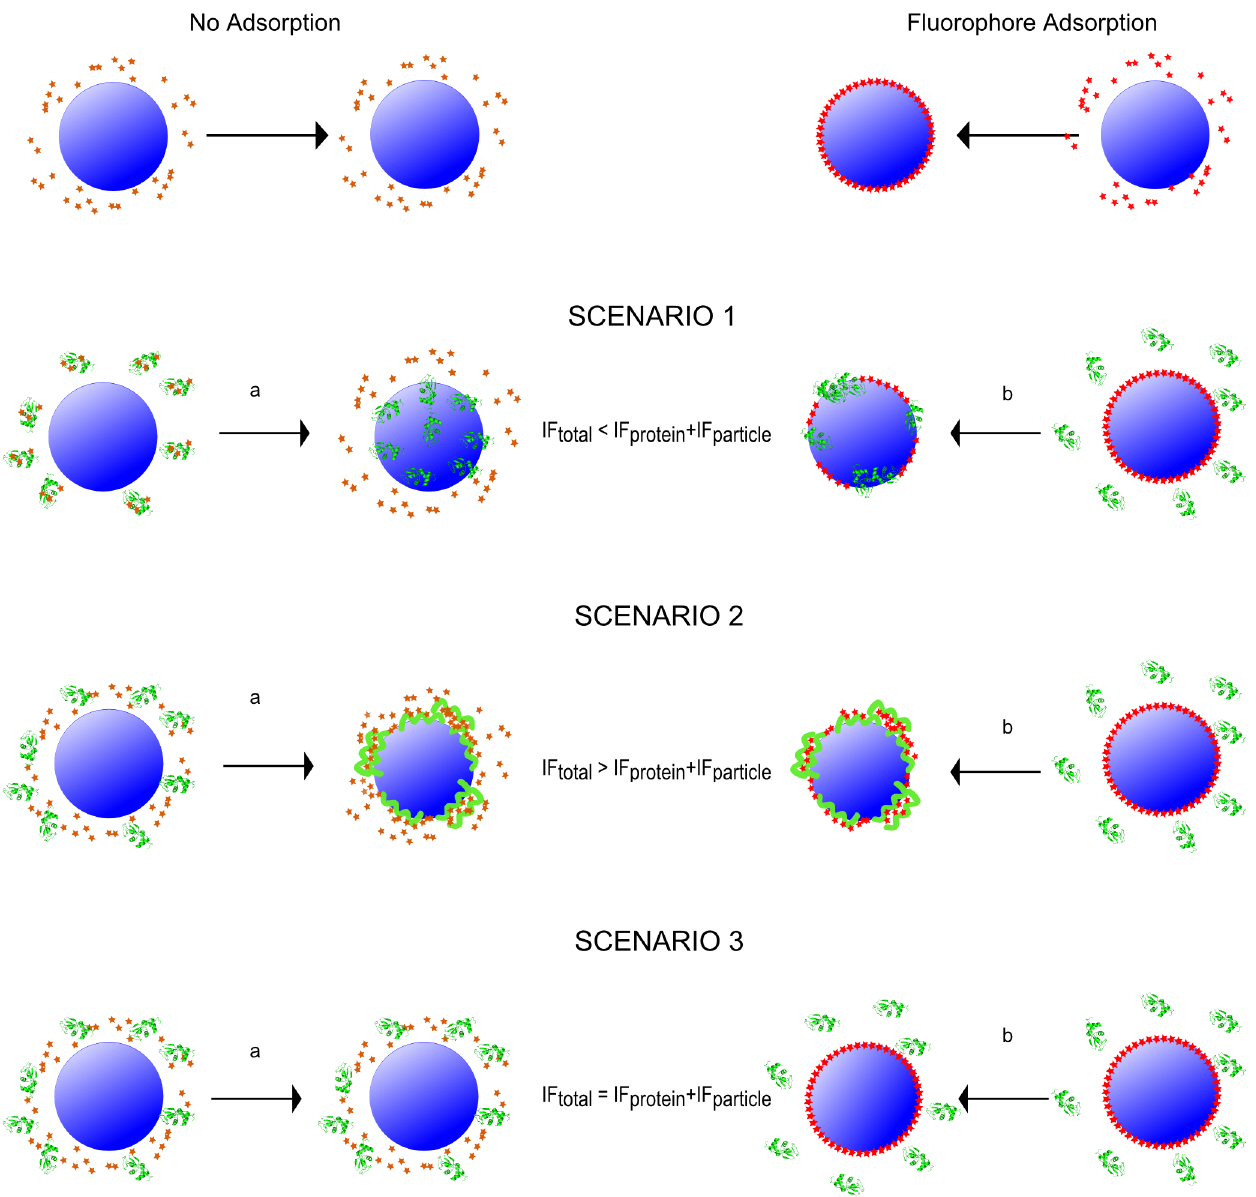
Fig 4. Schematic illustration of the 6 scenarios leading to the observed fluorescence intensity. Left side shows the situation when the fluorophore do not adsorb to the nanoparticle (1a, 2a, and 3a) and the right side shows the situations when the fluorophore do adsorb to the nanoparticles (1b, 2b, and